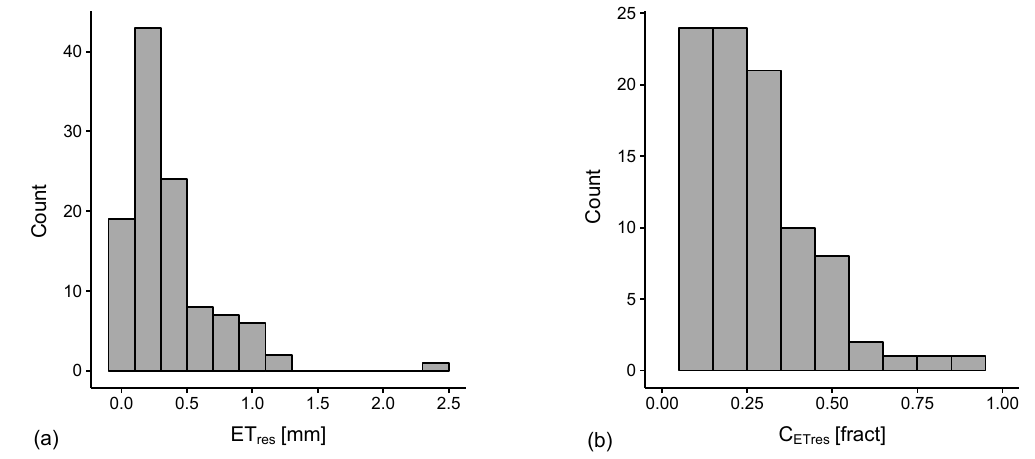
Figure 2. Distribution of the estimated intercepts. The majority of sites had values between 0 and 1.2mm for the absolute intercept (a) . The relative contribution of ET res to the daily mean evapotranspiration as quantified by C ETres reached up to 0.94 (b) . Table 1. Fraction of the 110 sites at which the model of the respective row was superior to the model of the respective column according to the MEF diff